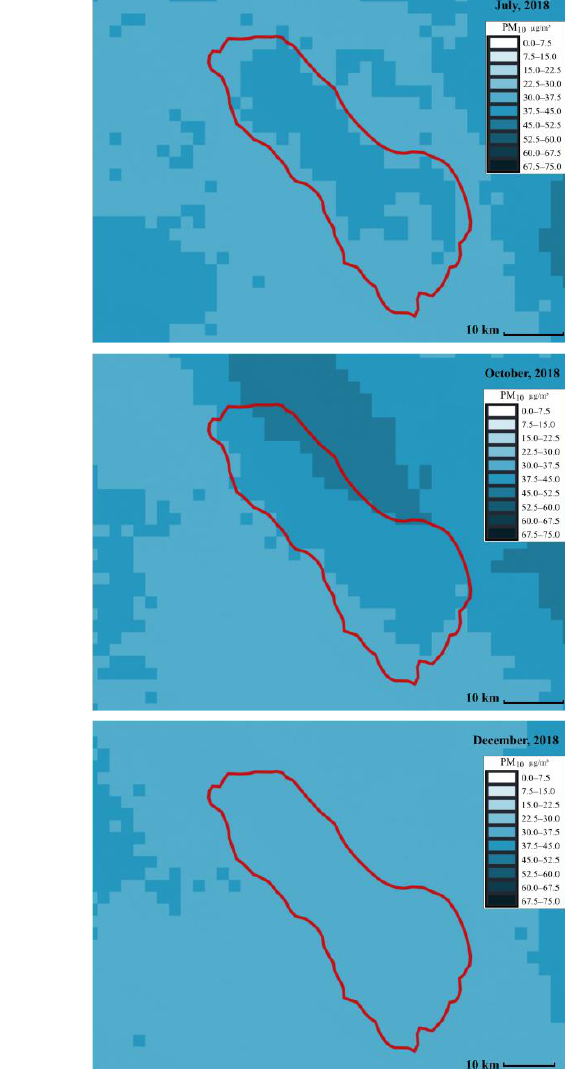
Table 7. Comparison of Models for Asthma Prediction (created by author).